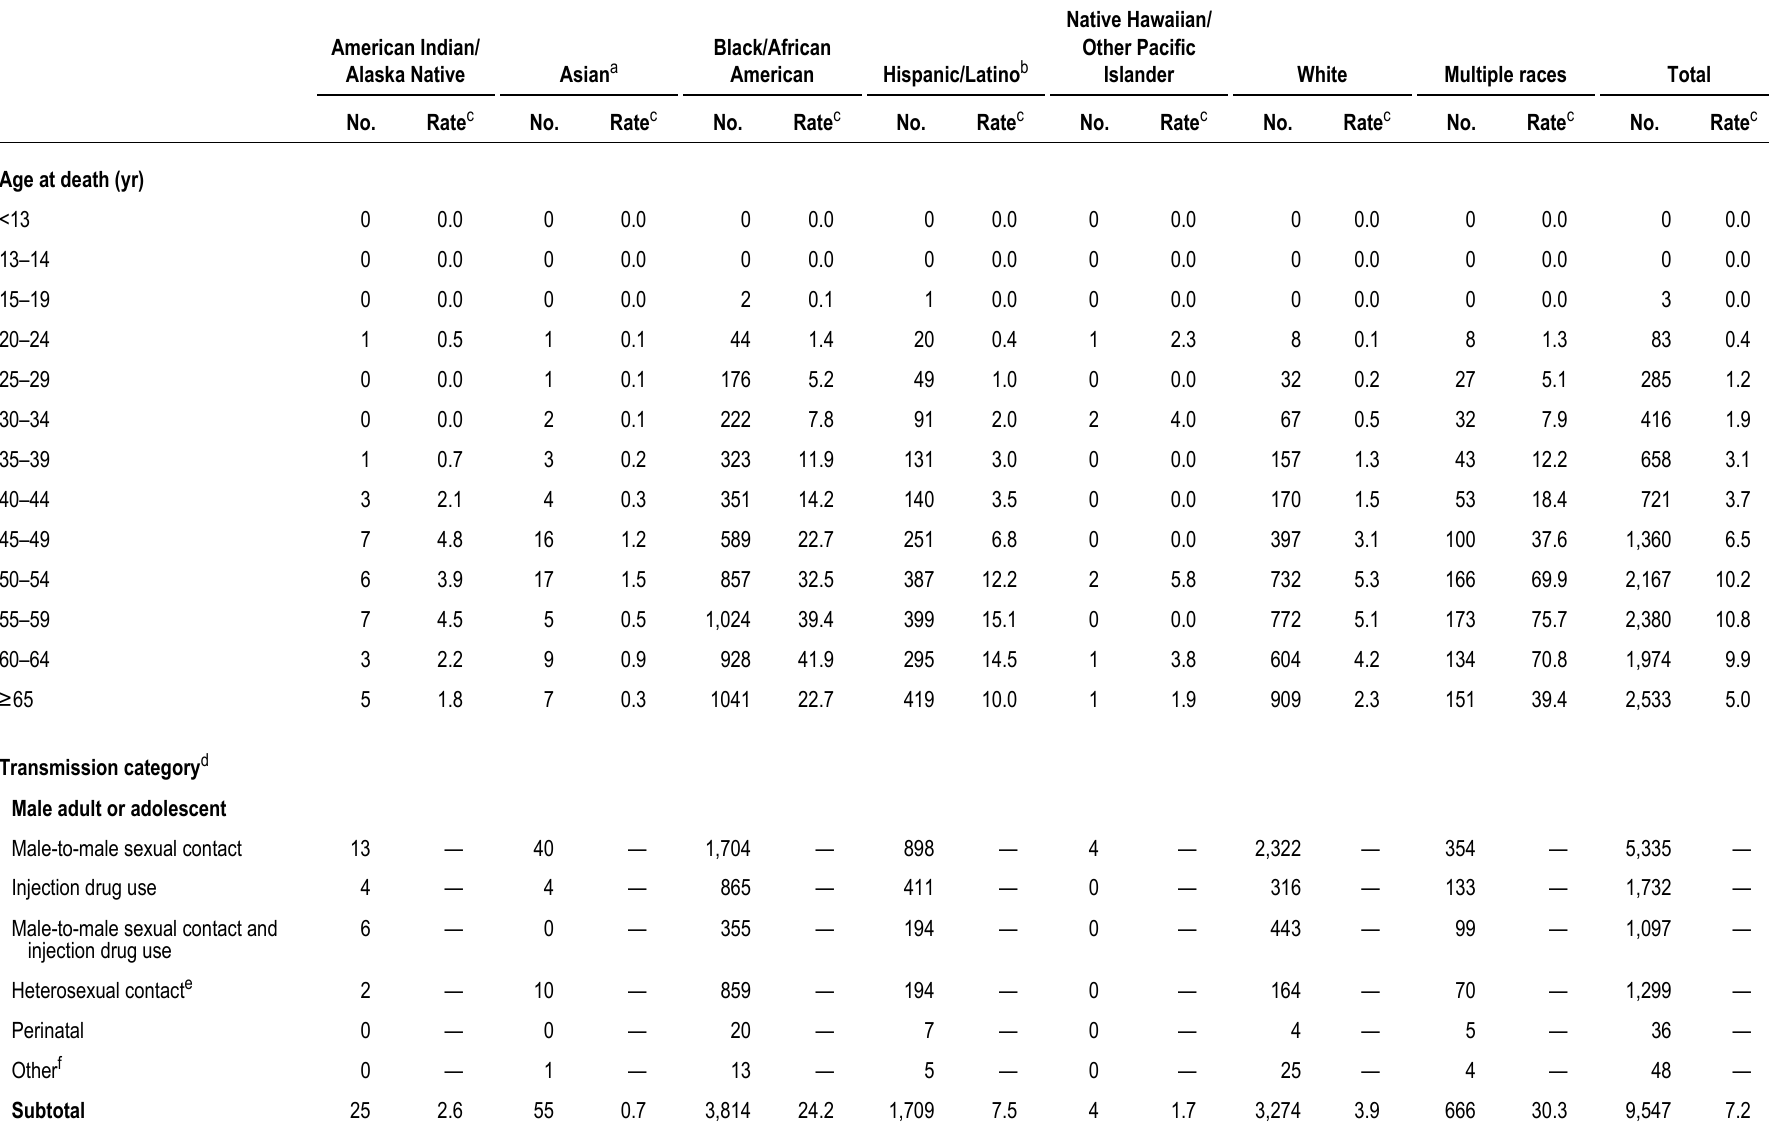
Table 21a. Deaths of persons with diagnosed HIV infection ever classified as stage 3 (AIDS), by race/ethnicity and selected characteristics, 2017—United States